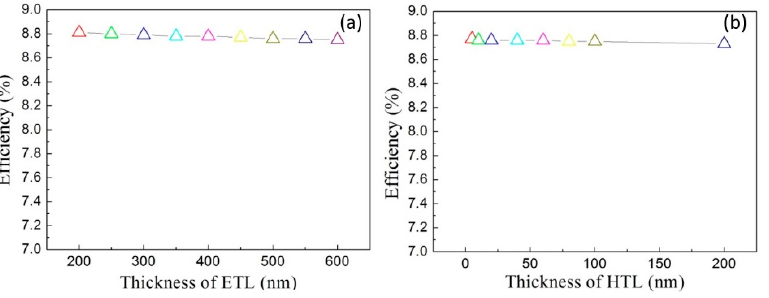
Figure 5. Thickness effect of ( a ) ETL and ( b ) HTL on the efficiency of the solar cell.